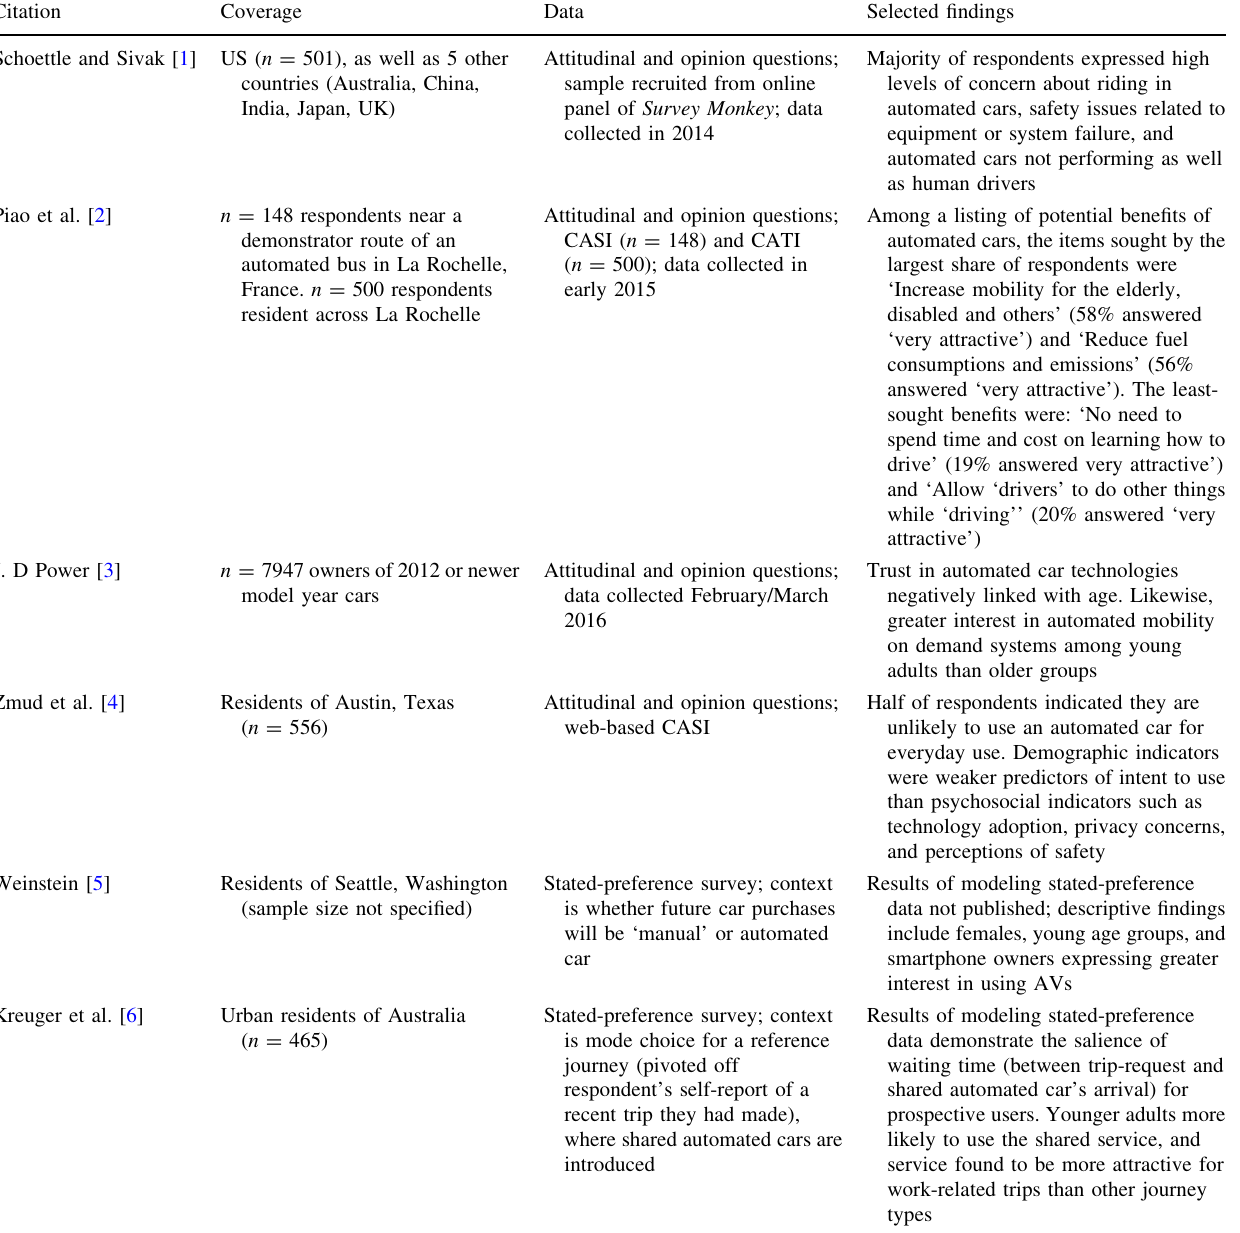
Table 1 Summary of earlier studies of attitudes and consumer preferences toward automated cars Citation Coverage